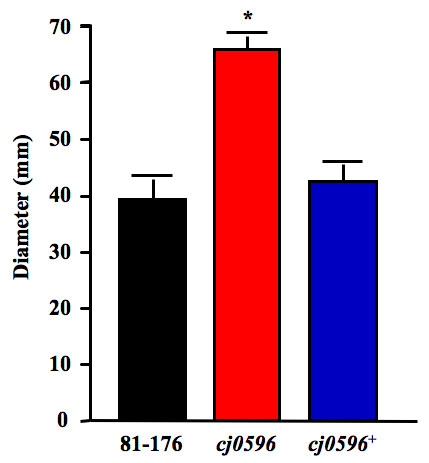
Motility of C. jejuni strains at 37°C. MH motility plates (0.4% agar) were inoculated with strains 81–176 (black), 81–176cj0596 (red) and 81–176cj0596+ (blue) and the zones of motility were measured after 48 hours. Statistical significance (p < 0.05) is represented by an asterisk.